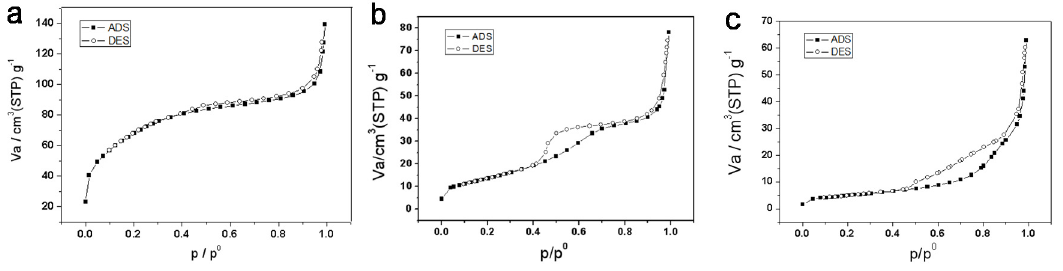
Figure 4. N 2 adsorption-desorption curves of titanium samples, ( a ) titanium precursor, ( b ) TiO 2 -550, ( c ) TiO 2 -800.